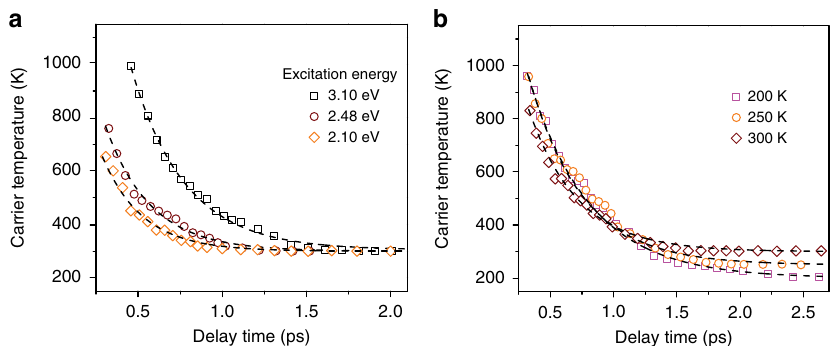
Fig. 2 HC cooling governed by the hot-phonon bottleneck effect at carrier densities around 10 18 cm − 3 . a HC cooling of MAPbI 3 fi lms excited with same n 0 of 4.2 × 10 18 cm − 3 but varying excitation energy. b Temperature-dependent HC cooling dynamics of MAPbI 3 fi lms excited at 2.48 eV with initial carrier density n 0 of 5.5 × 10 18 cm − 3 . The dashed lines are calculated HC cooling dynamics using our model (see main